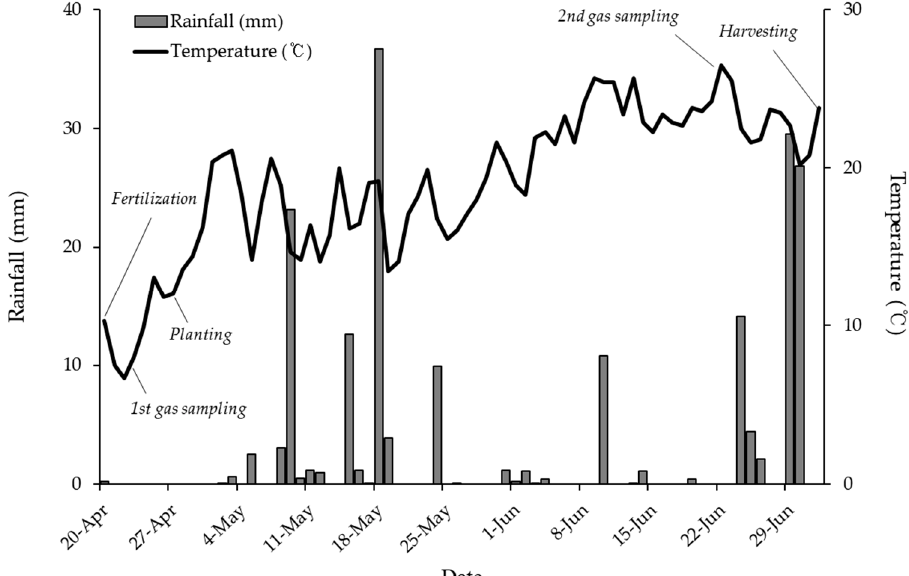
Figure 1. Mean rainfall and temperature in an upland during the field experiment, which were measured at Suwon weather station of Korea Meteorological Administration.